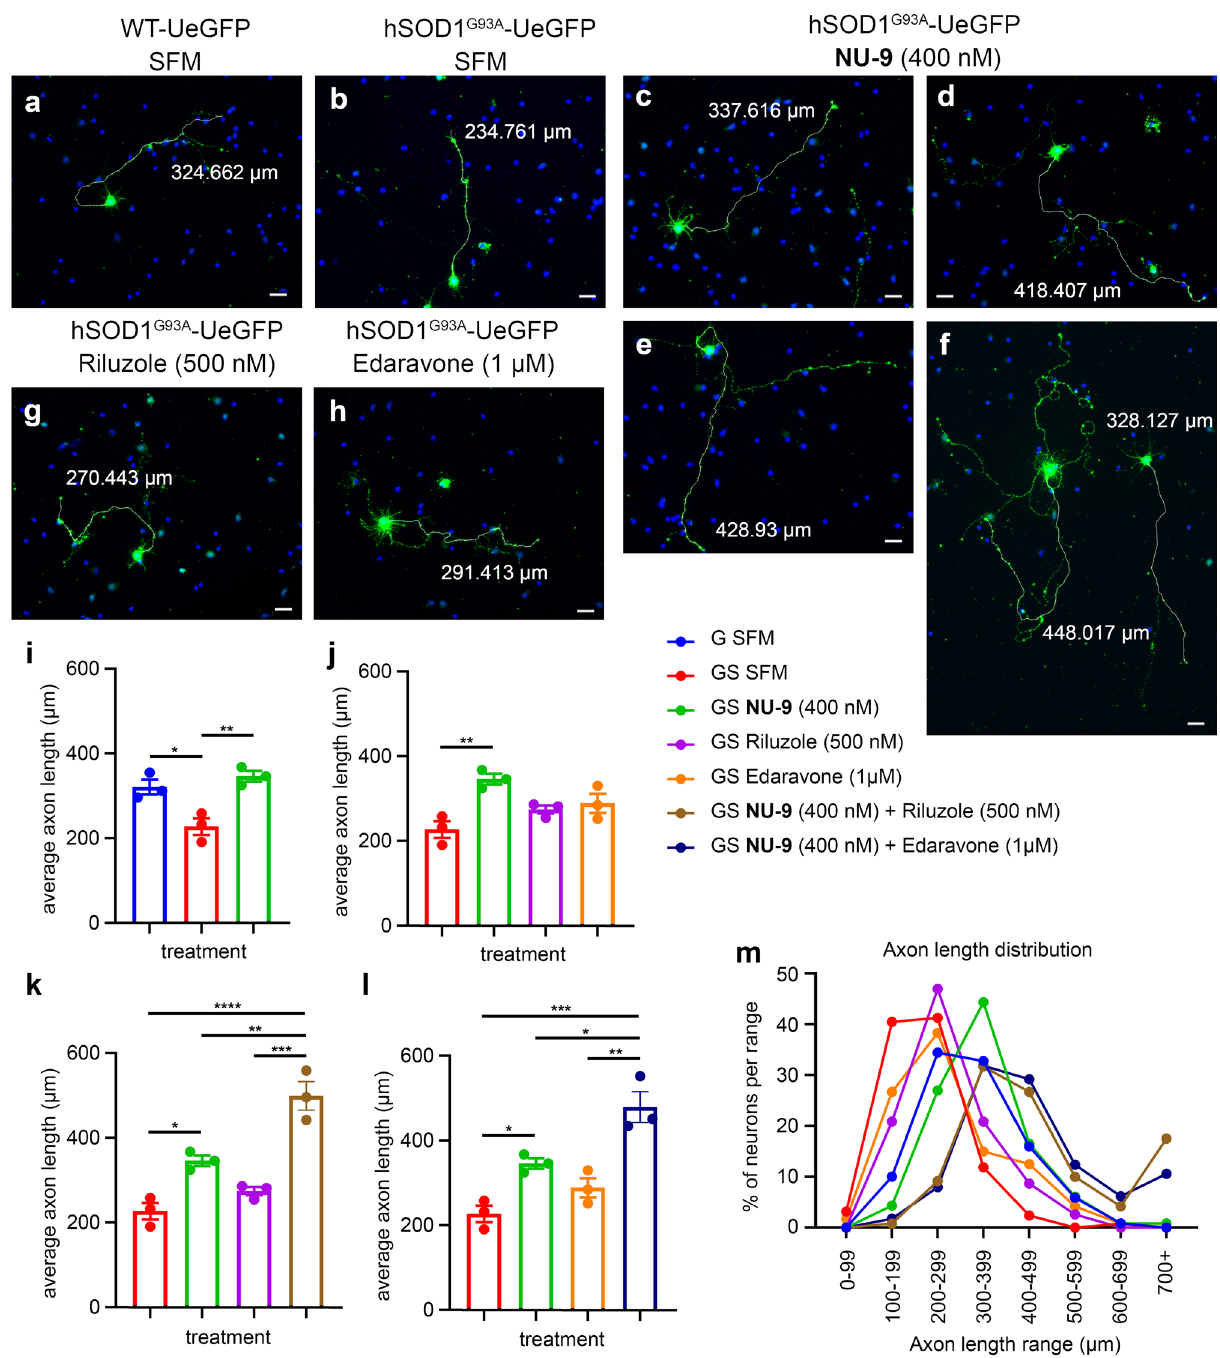
Figure 3. NU-9 enhances axon outgrowth of UMNs that become diseased by mSOD1 toxicity. ( a ) Representative images of UMNs in dissociated cell cultures of motor cortex isolated from WT-UeGFP and ( b ) hSOD1 G93A -UeGFP mice treated with SFM, ( c - f ) with 400 nM of NU-9, ( g ) 500 nM riluzole, ( h ) 1 µM edaravone for 3 days in vitro. Blue dots (DAPI) represent nuclei of other cells in culture, whereas UMNs are identified by their eGFP expression. ( i-l ) Average length of UMN axons in WT-UeGFP or hSOD1 G93A -UeGFP mice treated with 400 nM NU-9 (i) , 500 nM riluzole, 1 µM edaravone ( j ), or combination of NU-9 with riluzole ( k ) or edaravone ( l ). Mean, SEM, and individual data points shown for n = 3 biological replicates. * p < 0.05, ** p < 0.01, *** p < 0.001, **** p < 0.0001, one-way ANOVA followed by Tukey’s post hoc multiple-comparison test. ( m ) Percent distribution of UMNs based on axon length in WT-UeGFP or hSOD1 G93A -UeGFP mice treated with 400 nM NU-9 , 500 nM riluzole, 1 µM edaravone, or a combination of NU-9 with riluzole or edaravone. Untreated WT-UeGFP (blue), untreated hSOD1 G93A -UeGFP (red), hSOD1 G93A -UeGFP treated with NU-9 (green), edaravone (orange), riluzole (purple), NU-9 and edaravone (dark blue), NU-9 and riluzole (brown). SFM = serum free medium; G = WT-UeGFP; GS = hSOD1 G93A -UeGFP. Scale bars, 25 μm; n= 3 biological